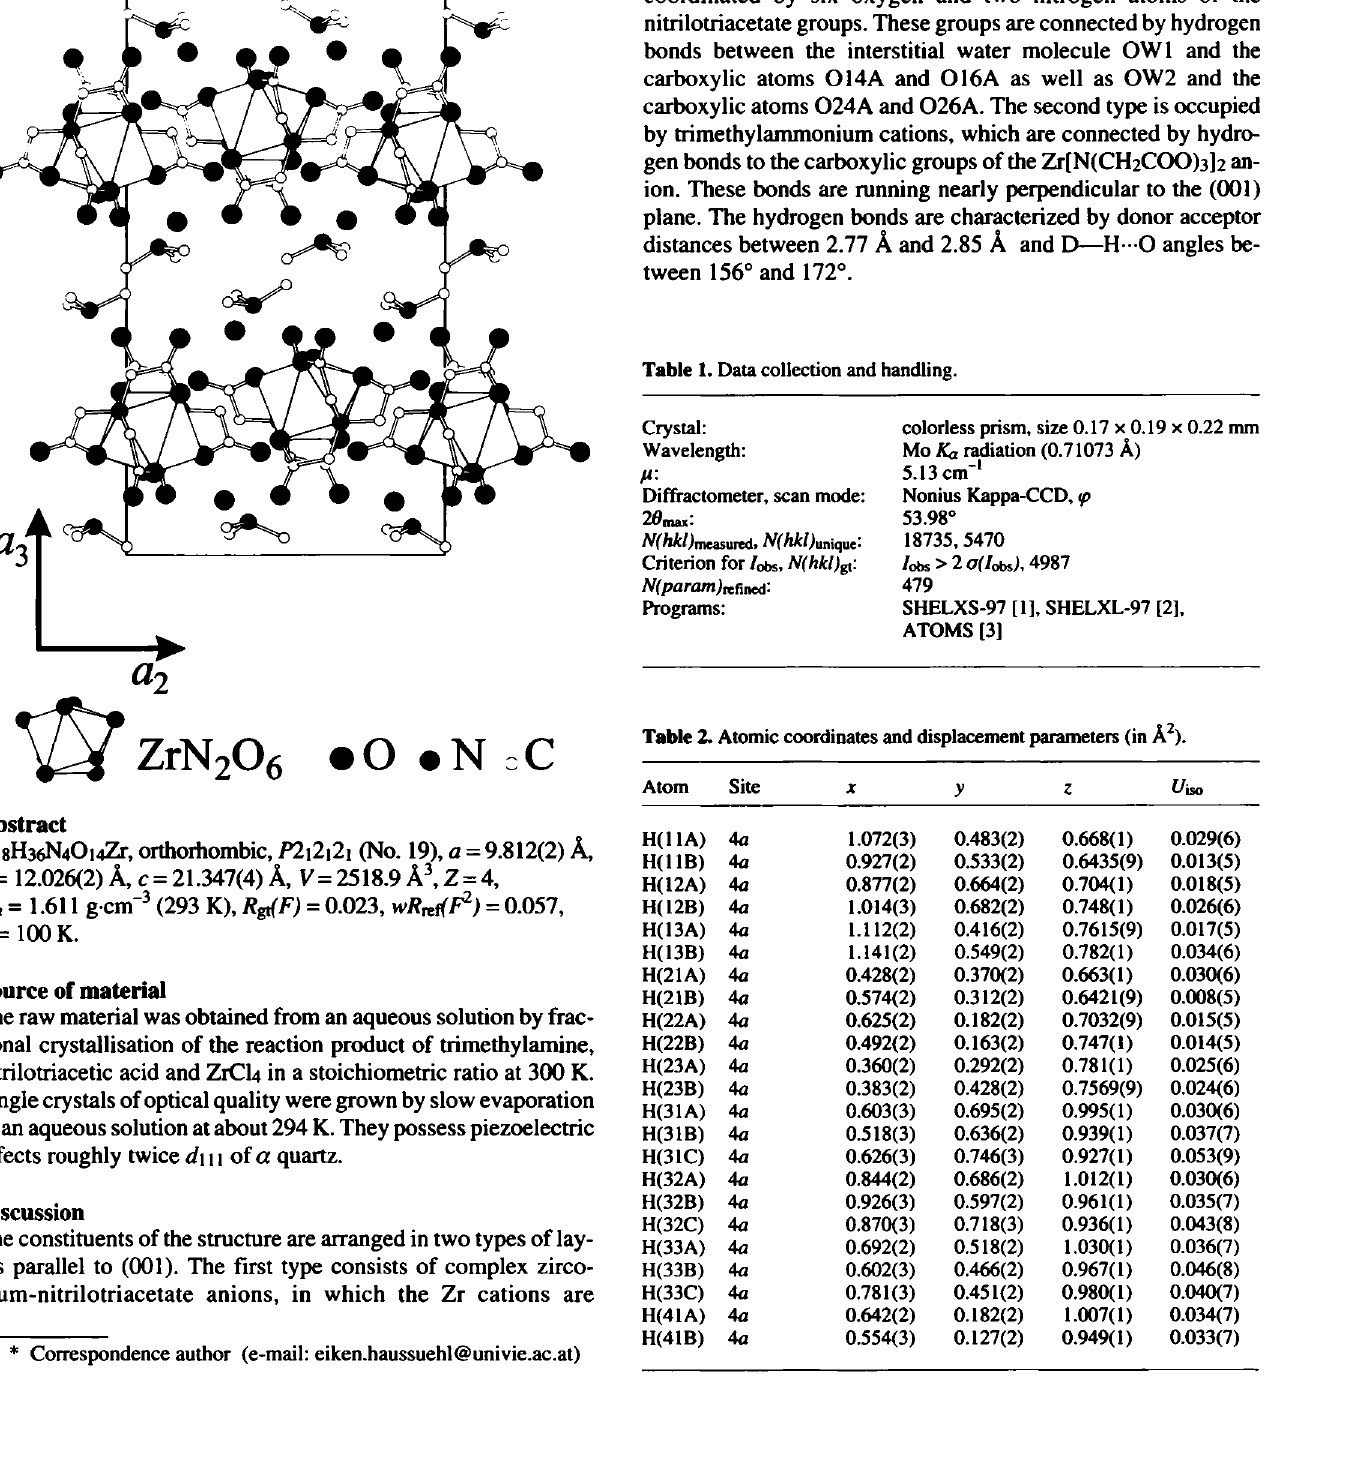
Table 2. Atomic coordinates and displacement parameters (in Â 2